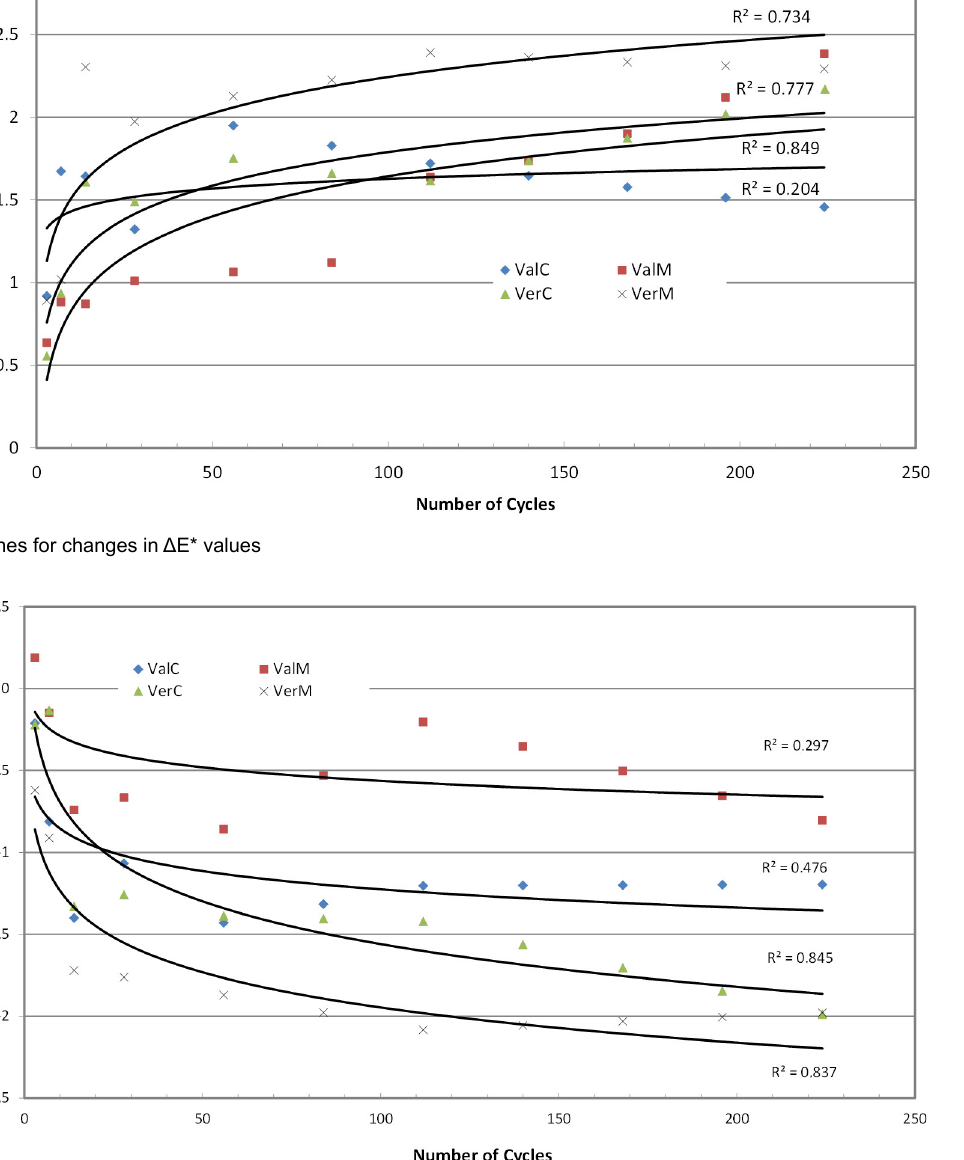
Figure 4- Trend lines for changes in ΔL*